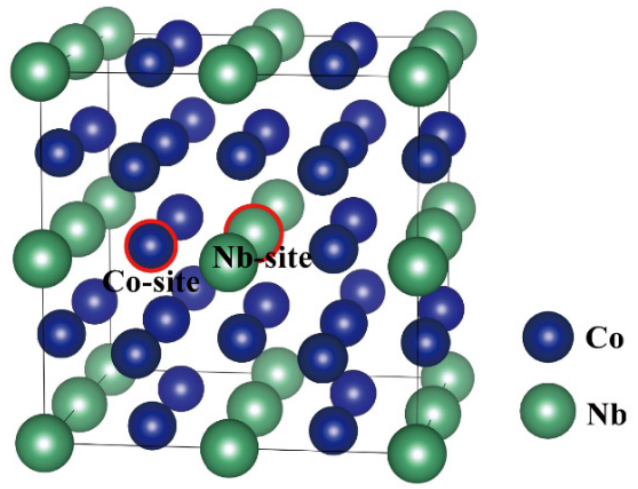
Figure 1. Co 3 Nb compound with L1 2 structure. The marked balls represent sites substituted by transition metal X.